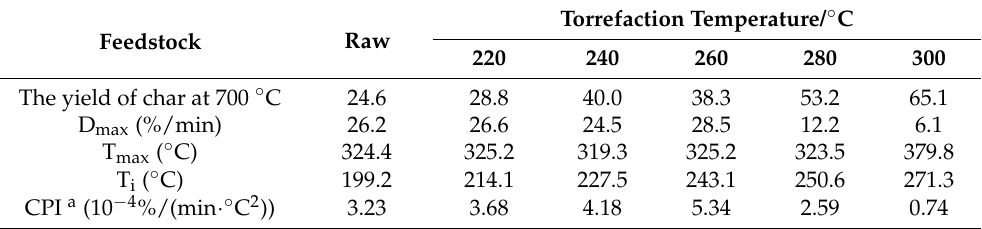
Table 2. The pyrolysis characteristic parameters obtained from the TG/DTG curves for pyrolysis of raw and torrefied corn cobs. Torrefaction Temperature/ ◦ C Feedstock Raw 220 240 260 280 300 The yield of char at 700 ◦